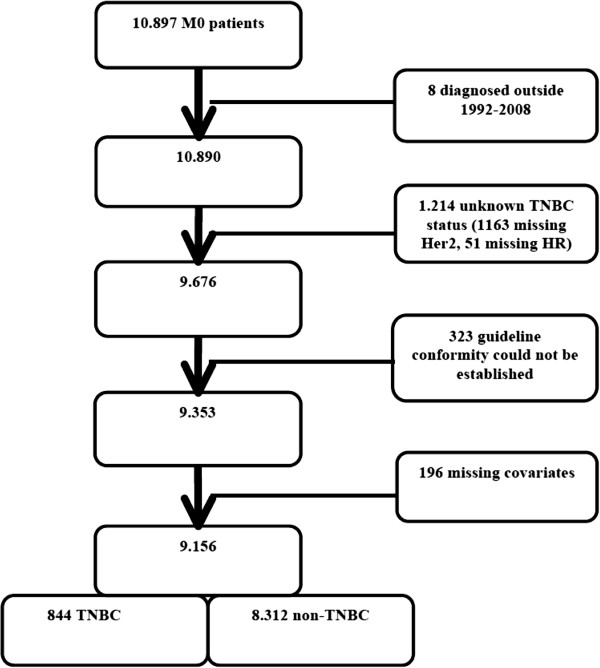
Cohort diagram of the study group.